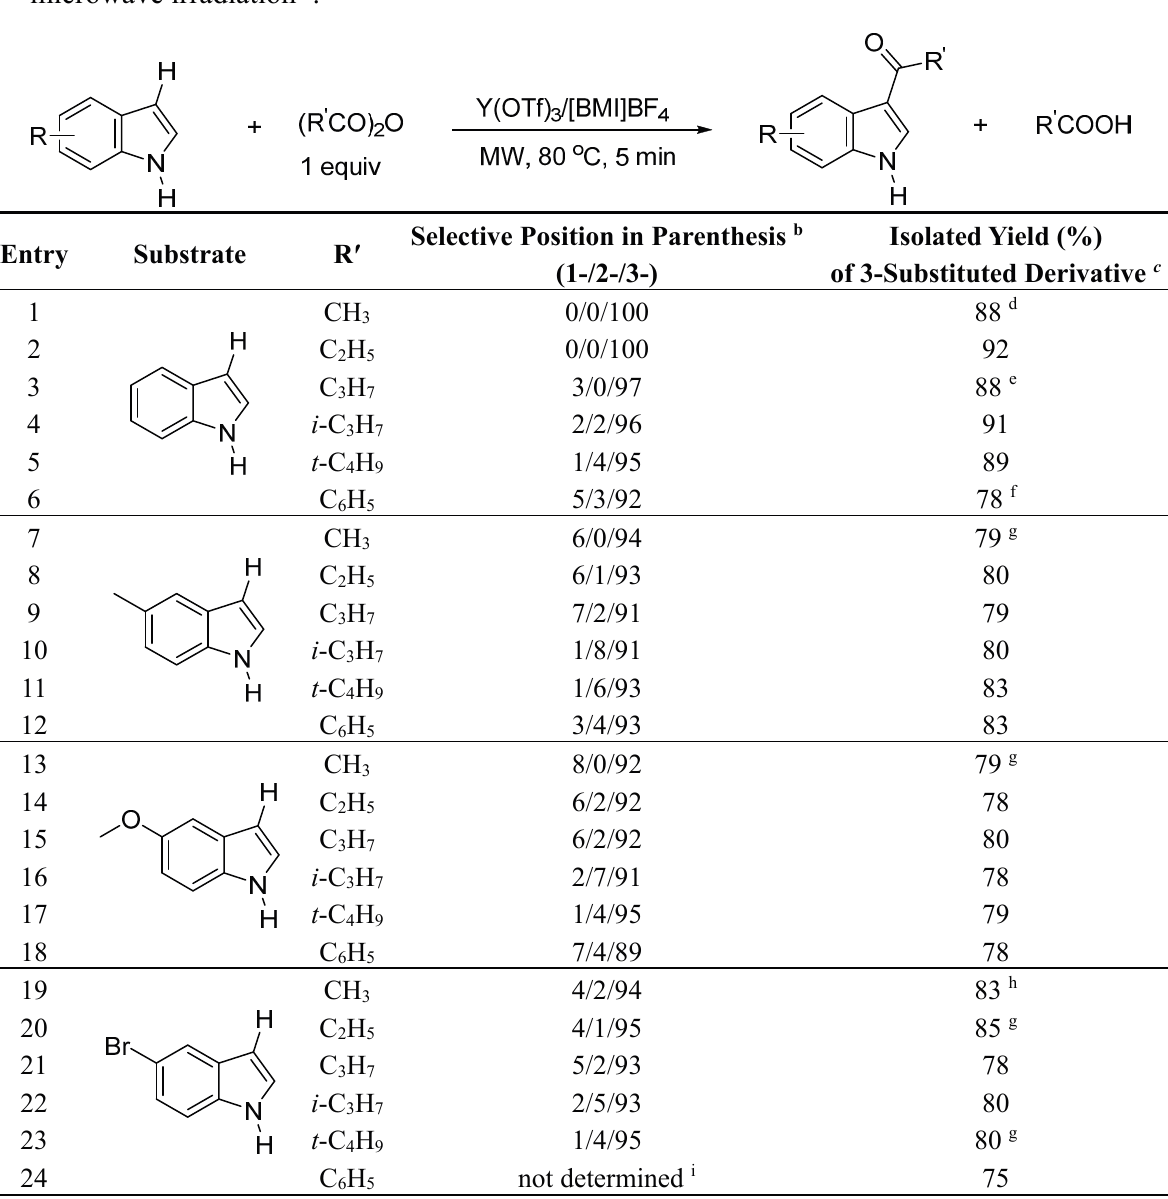
Table 3. Friedel-Crafts acylation of indoles using Y(OTf) 3 /[BMI]BF 4 under monomode microwave irradiation a